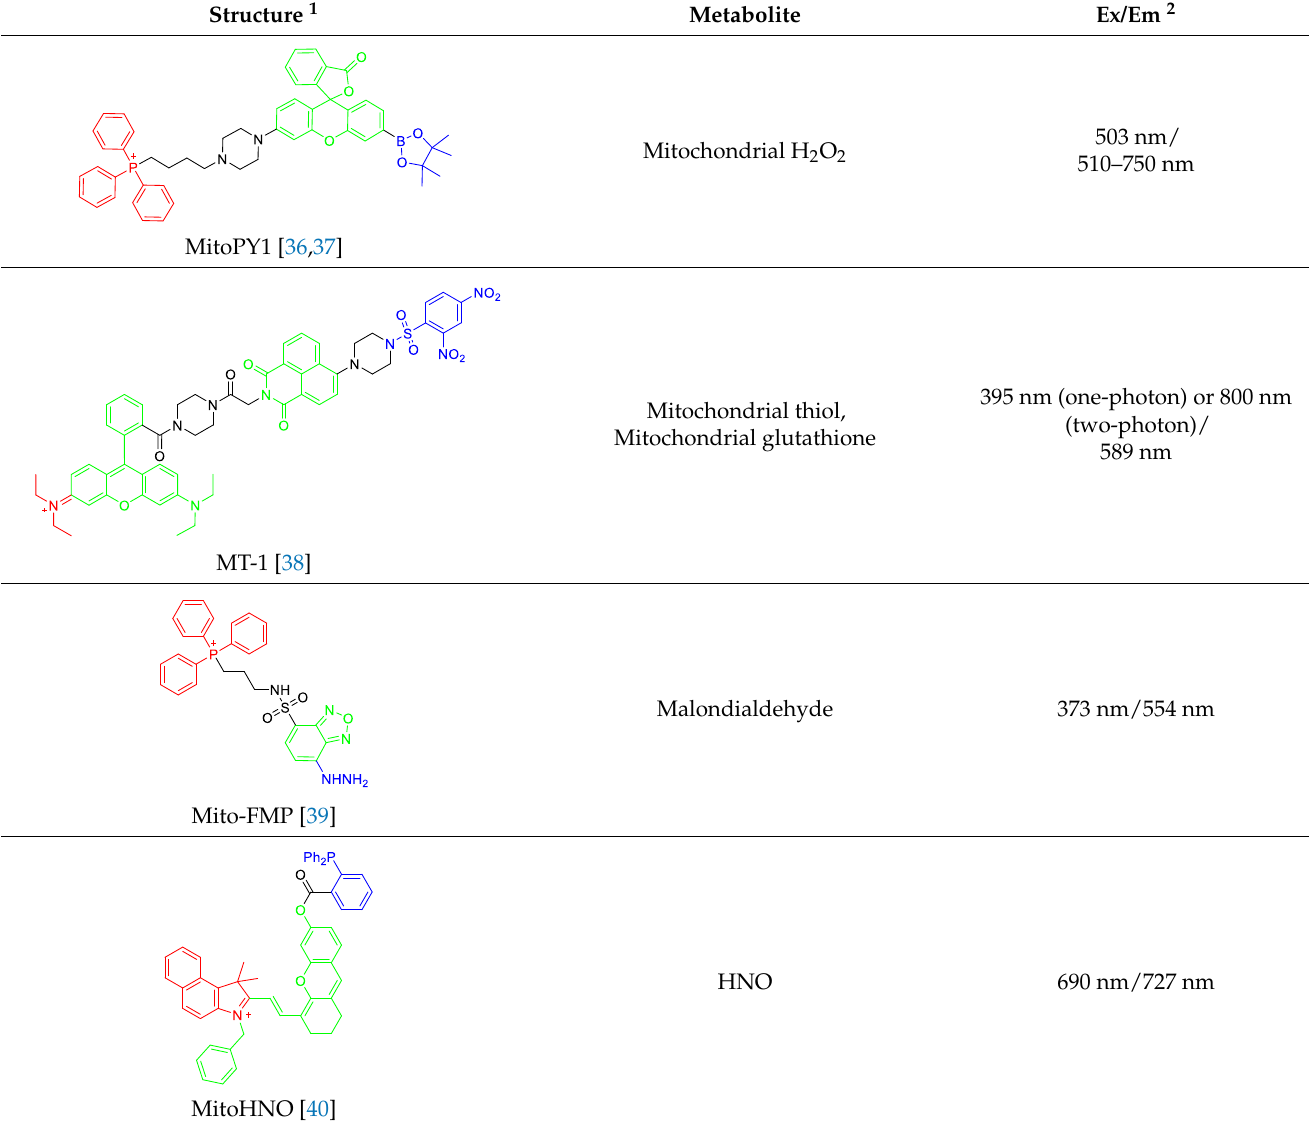
Table 1. Summary of the chemical probes for targeting various types of mitochondrial